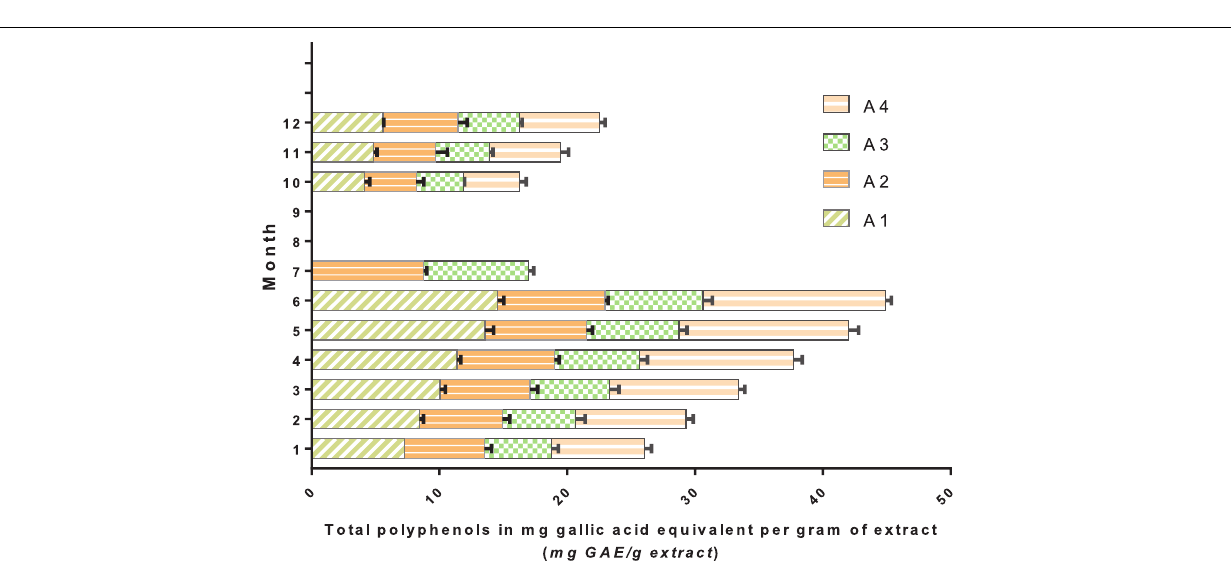
Frontiers in Ecology and Evolution |